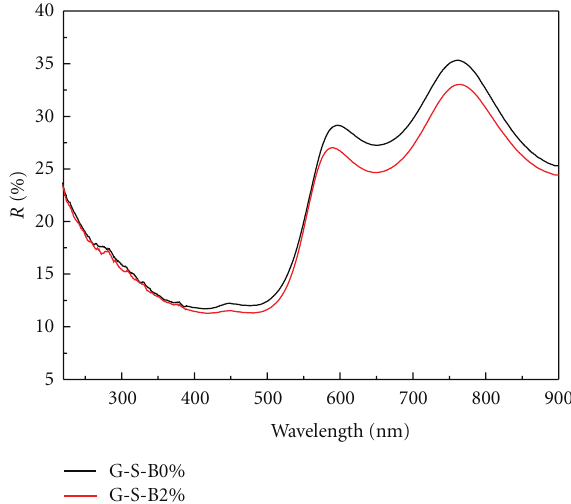
Figure 3: UV-visible light reflection spectrum of goethite and B- doped